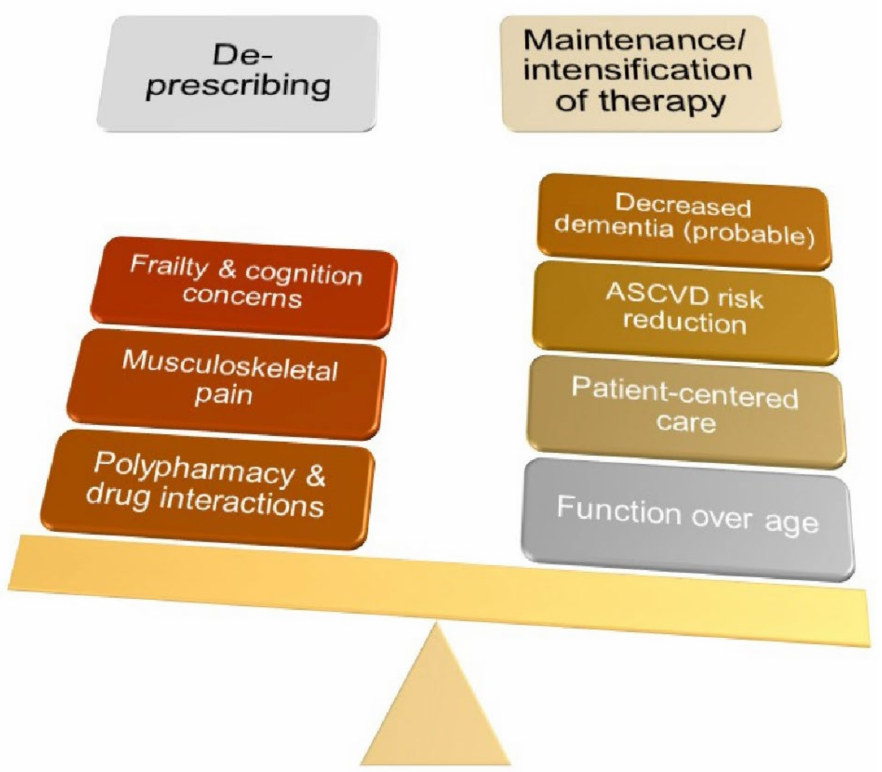
Figure 1. Conceptual diagram. Various potential issues influencing the risk and benefit balance in favor of or against the use of lipid-lowering pharmacotherapies in older individuals are